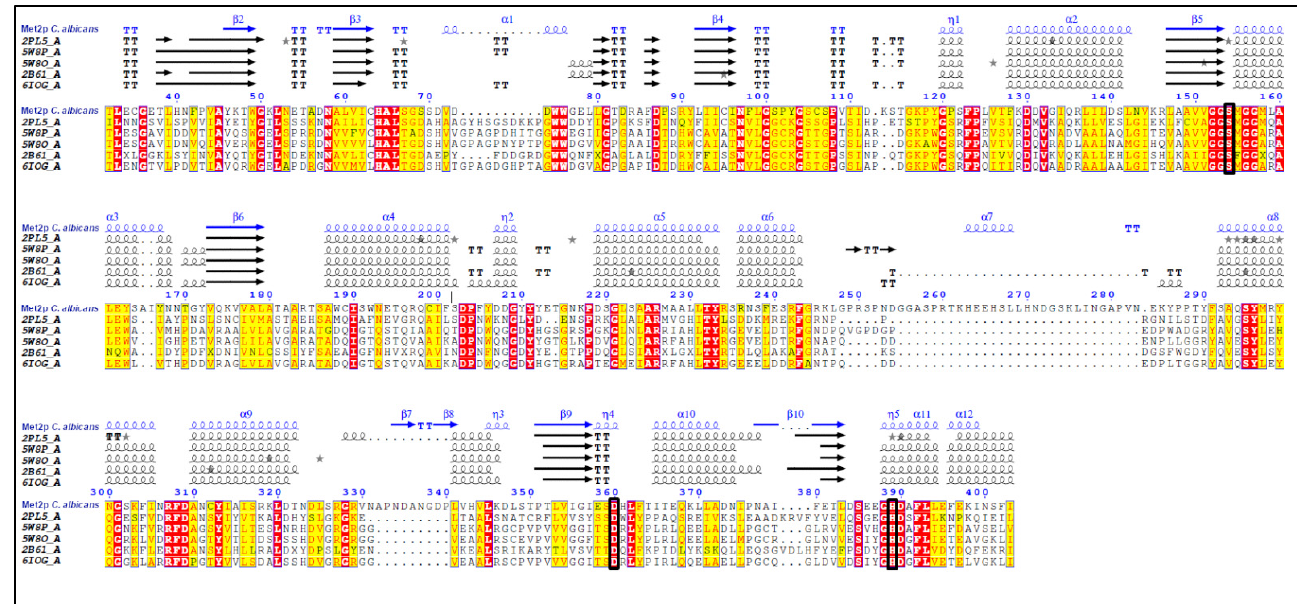
Figure 2. The multiple sequence alignment of the amino acid sequence of Ca Met2p and homologous sequences of L-homoserine O -acetyltransferases, with determined 3D structures from the PDB database. Comparison of the predicted secondary structure of Ca Met2p with those of the other known L-homoserine O -acetyltransferases. Analysis performed using the ENDscript program [19]. Sequence numbering refers to Ca Met2p. Residues 1–31 and 404–409 are not present. Colors: red—identity, yellow—similarity, symbols: α , α -helix; β , β -sheets; η , 3 10 -helices; TT, strict β -turns; (cid:70) , residues with alternate conformations. The probable catalytic amino acids: Ser 154 , Asp 360 , and His 389 in the Ca Met2p sequence are shown in the black square frame. PDB codes: 5W8O Mycobacterium hassiacum , 5W8P Mycobacterium abscessus , 6IOG Mycobacterium smegmatis , 2B61 Haemophilus influenza , and 2PL5 Leptospira interrogans